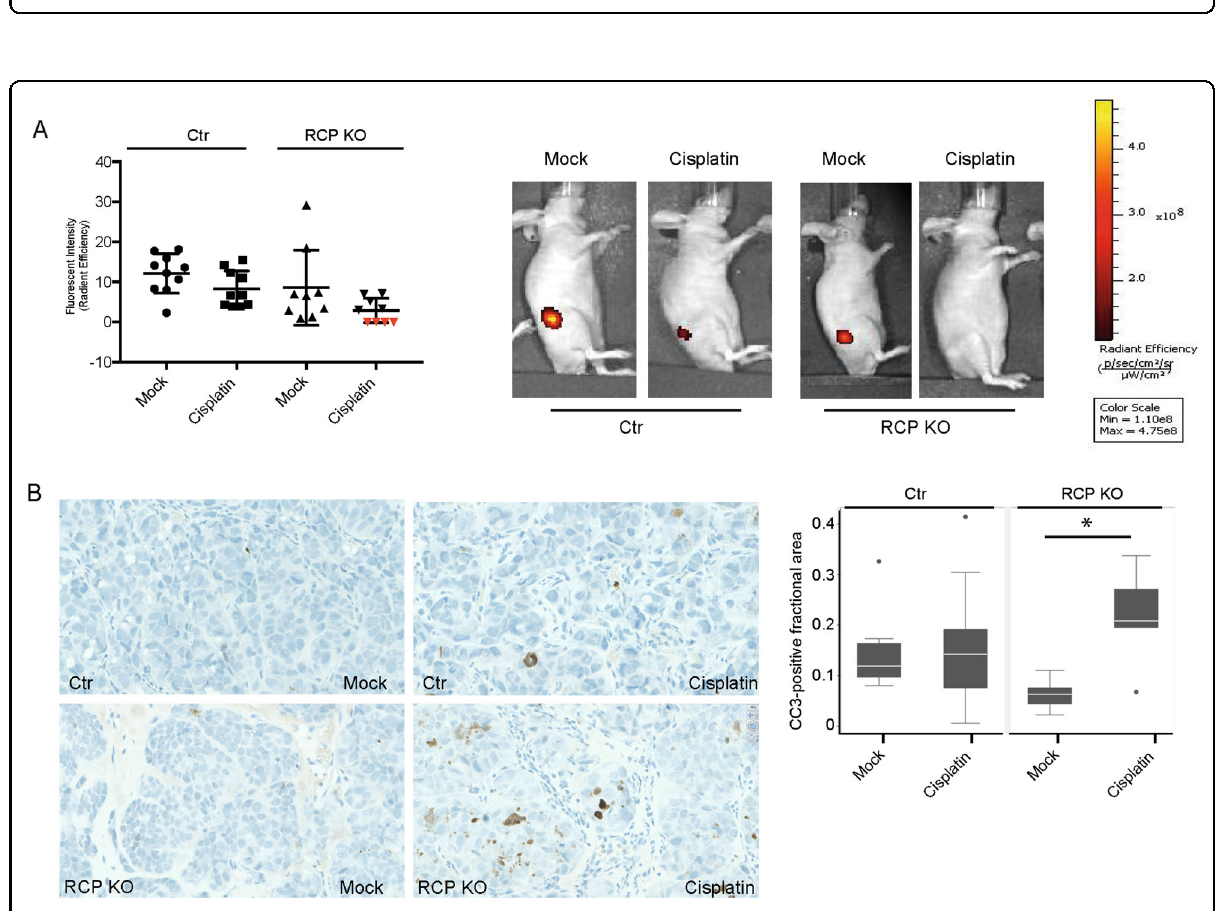
Fig. 2 RCP KO cells are more sensitive to cisplatin in vivo. A mCherry-expressing A431 control and A431 RCP KO cells were injected subcutaneously and treated with cisplatin (cisplatin 5 mg/kg, intraperitoneally) or a vehicle control. The tumour size was inferred using fl uorescence and quanti fi ed using the IVIS software. Error bars indicate SD. Red triangles indicate no measured signal and therefore measurements were set to 0. Representative images of iRFP signals in mice are shown in the right panels. B Cleaved caspase-3-positive areas were determined in each tumour and representative images are shown in the left panels, and plotted for each group in the right panel. Error bars indicate SD and * indicates a statistically signi fi cant difference ( P = 0.01). Differences between growth rates and fractional cleaved caspase-positive areas were assessed by Mann-Whitney two-sample statistic with Stata SE 13.1. Scale: 40X.